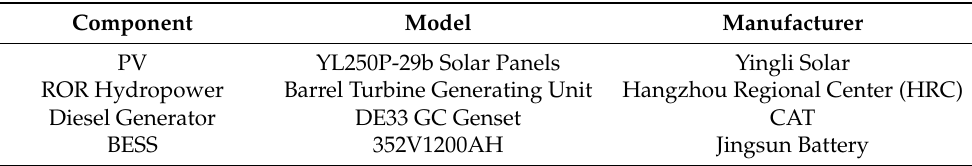
Table 3. HREM component model and manufacturer.